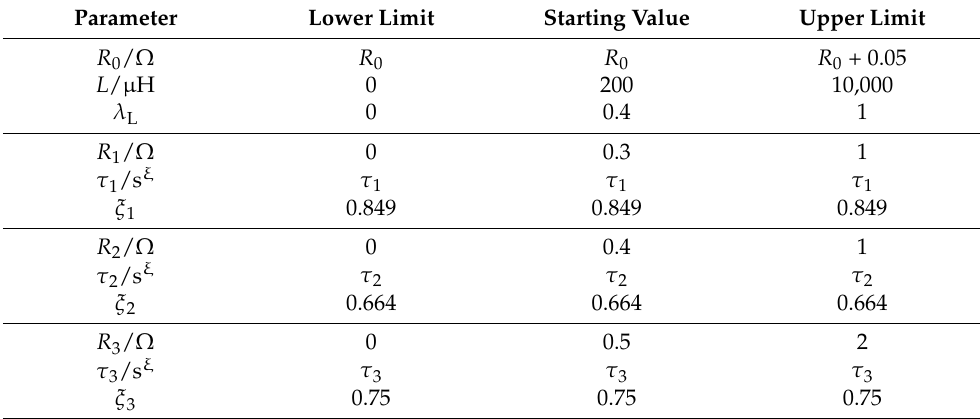
Figure 7. Negative half-cell EIS at 80% SoC and fit with ECM of the laboratory test cells for ( a ) complete cell: 8P8N/8P9N, ( b ) middle size cell: 3P2N and ( c ) small size cell: 2P1N visualized in a Nyquist diagram. Table 5. Starting parameters, lower and upper limits for the ECM fit.